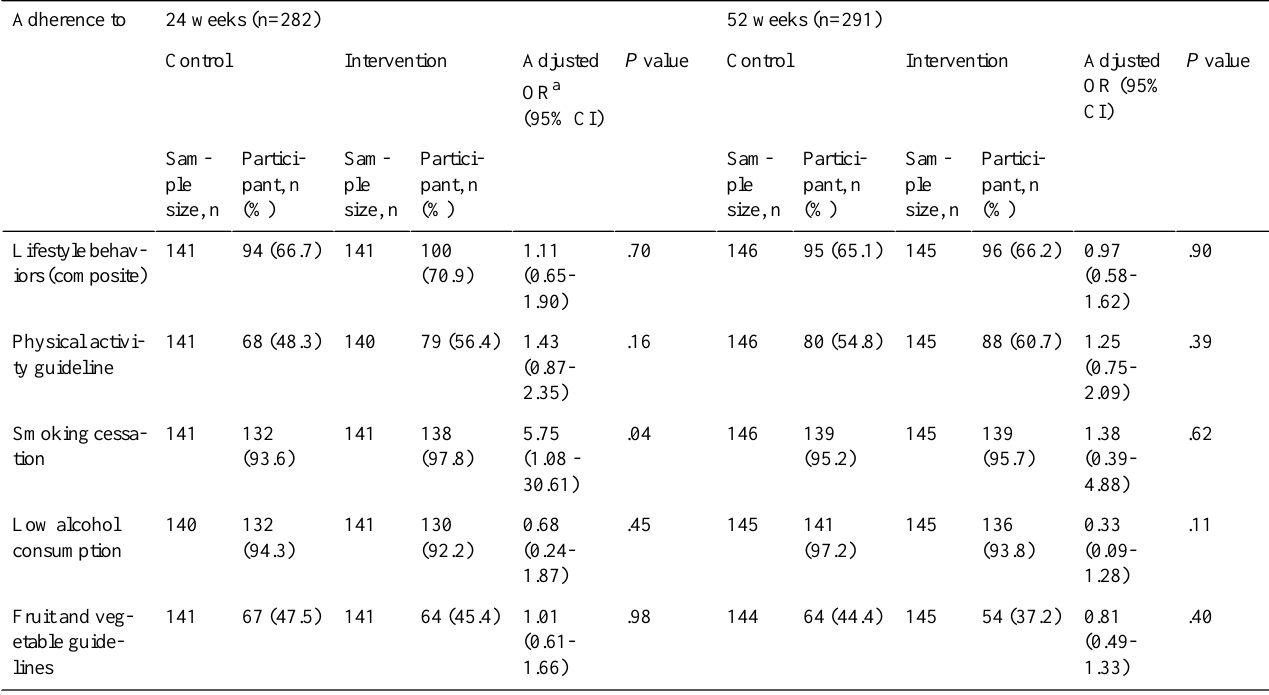
Table 3. The effect of intervention on adherence to lifestyle risk factors (secondary outcomes) at 24- and 52-week follow-up.